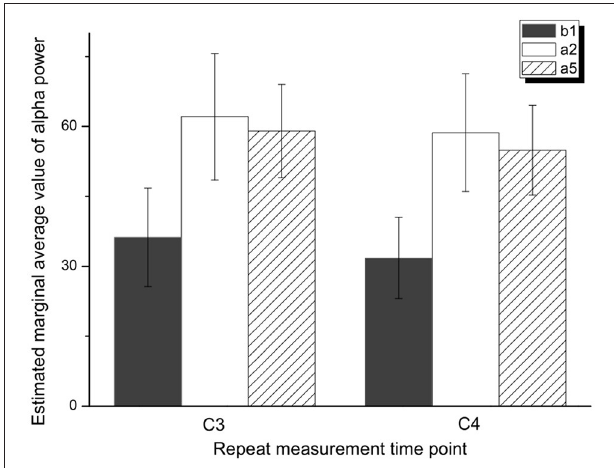
FIGURE 5 | Variance analysis of repeated measurement of α absolute power in C3 and C4